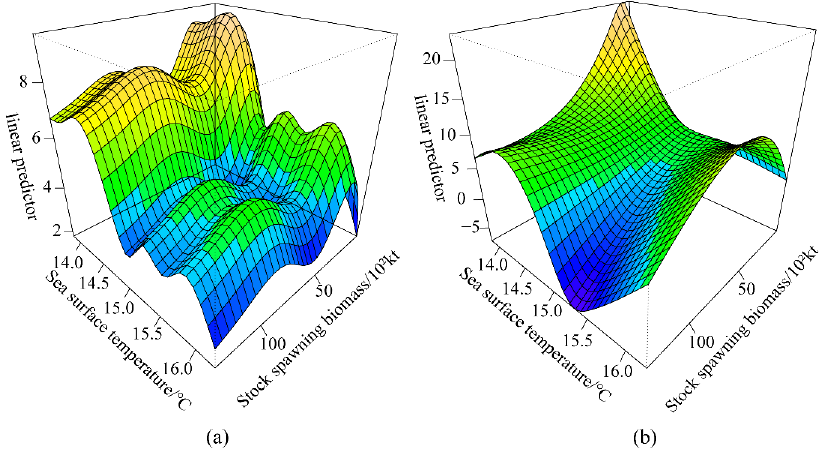
Figure 8. Interaction effects of the optimal GAM. ( a ) Possible interaction between environmental factors SST and spawning ( b ) Significant interaction between SST and spawning.